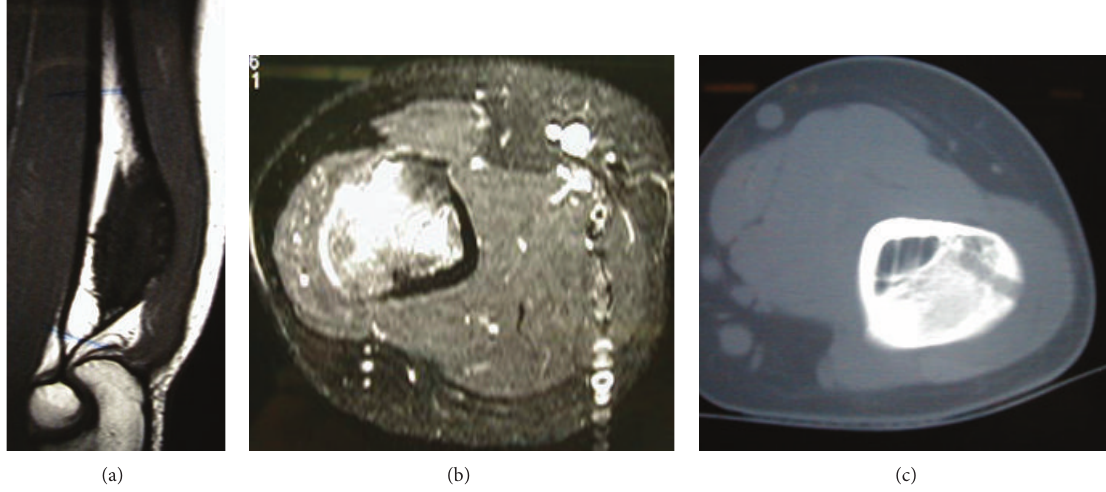
Figure 2: The MRI images show an exostosis arising from the posterior surface of the distal humerus. This lesion measured approximately 6 cm in its long axis terminating immediately proximally to the level of the olecranon and with involvement of the underlying medulla. You can see the sign of the biopsy (c).